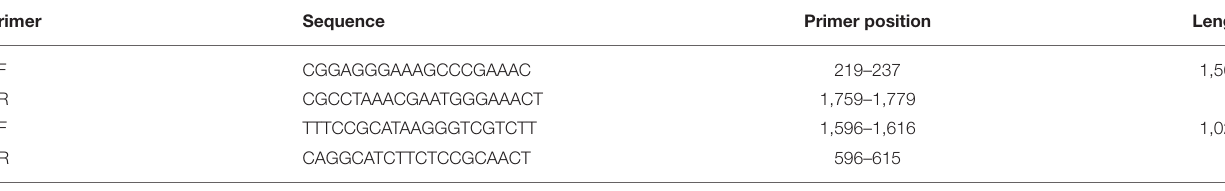
TABLE 3 | Primers used in this study to amplify the complete genome of PCV3. Primer